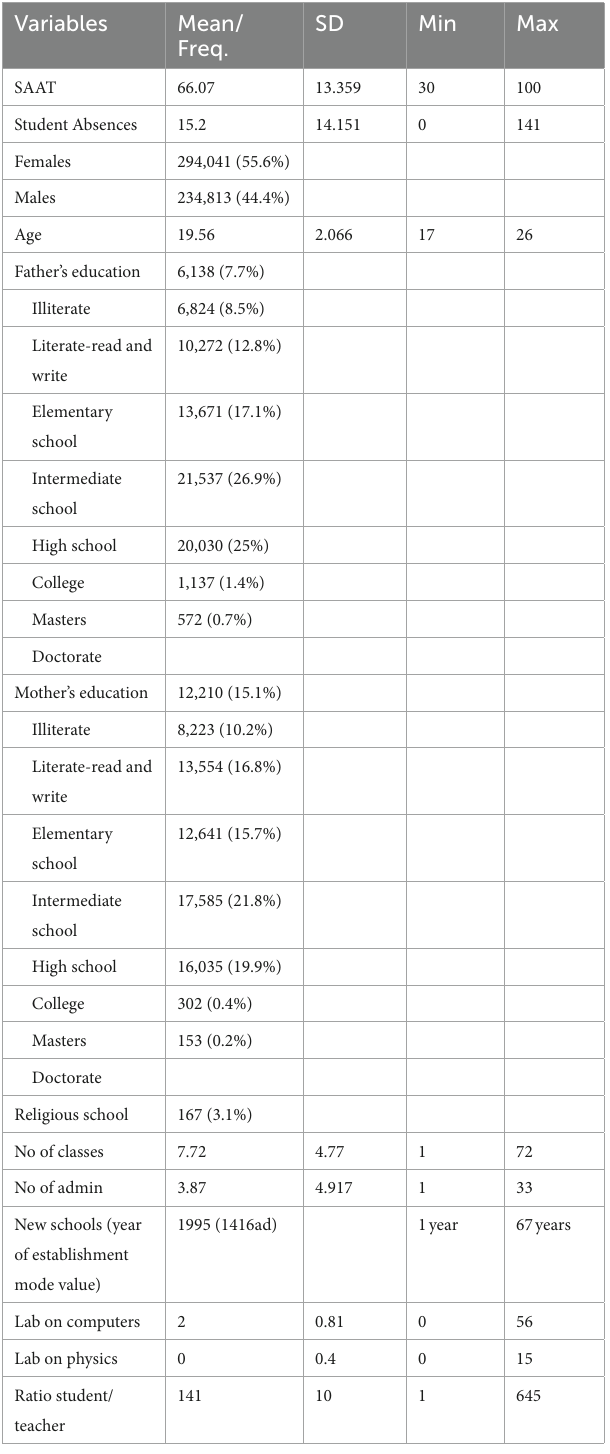
TABLE 2 Prerequisites to multilevel modeling with random effects.